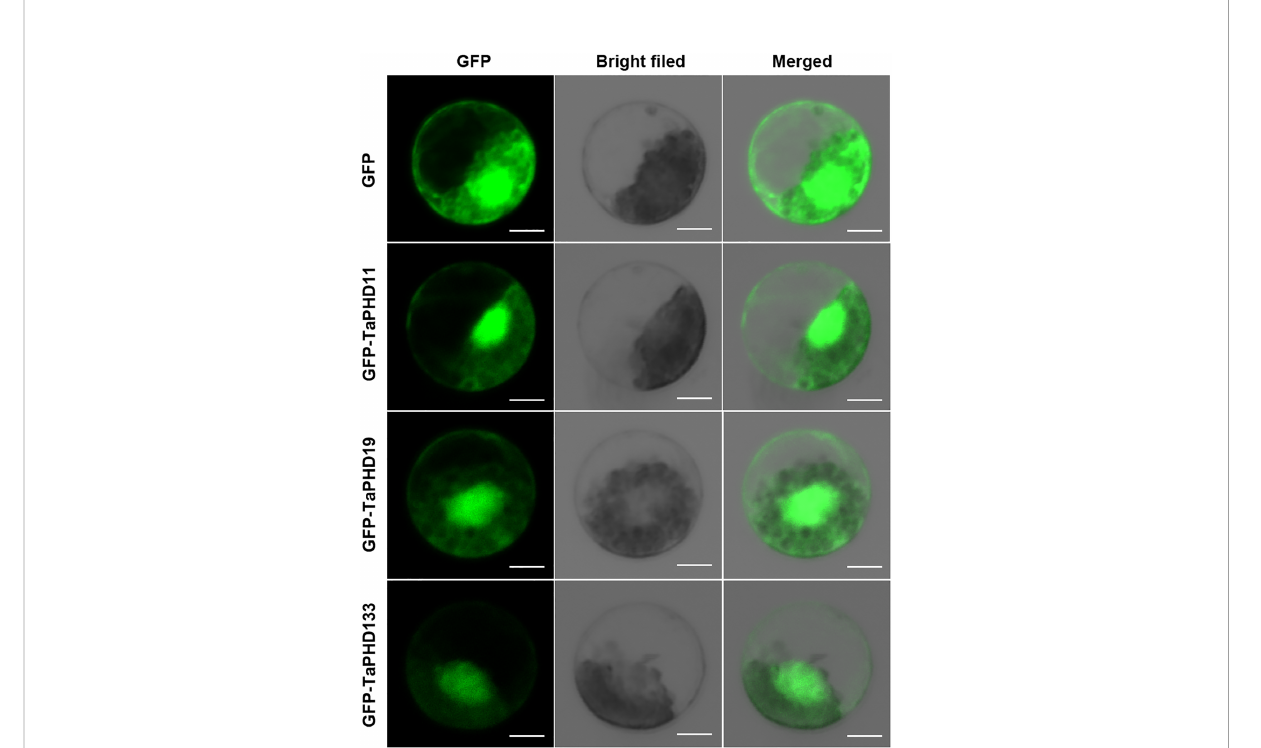
FIGURE 12 Subcellular location of TaPHD11 , TaPHD19 , and TaPHD133 . Localization of TaPHD proteins under normal conditions. Images were observed under a confocal laser scanning microscope (LSM 700, Zeiss). Scale bars = 10 m